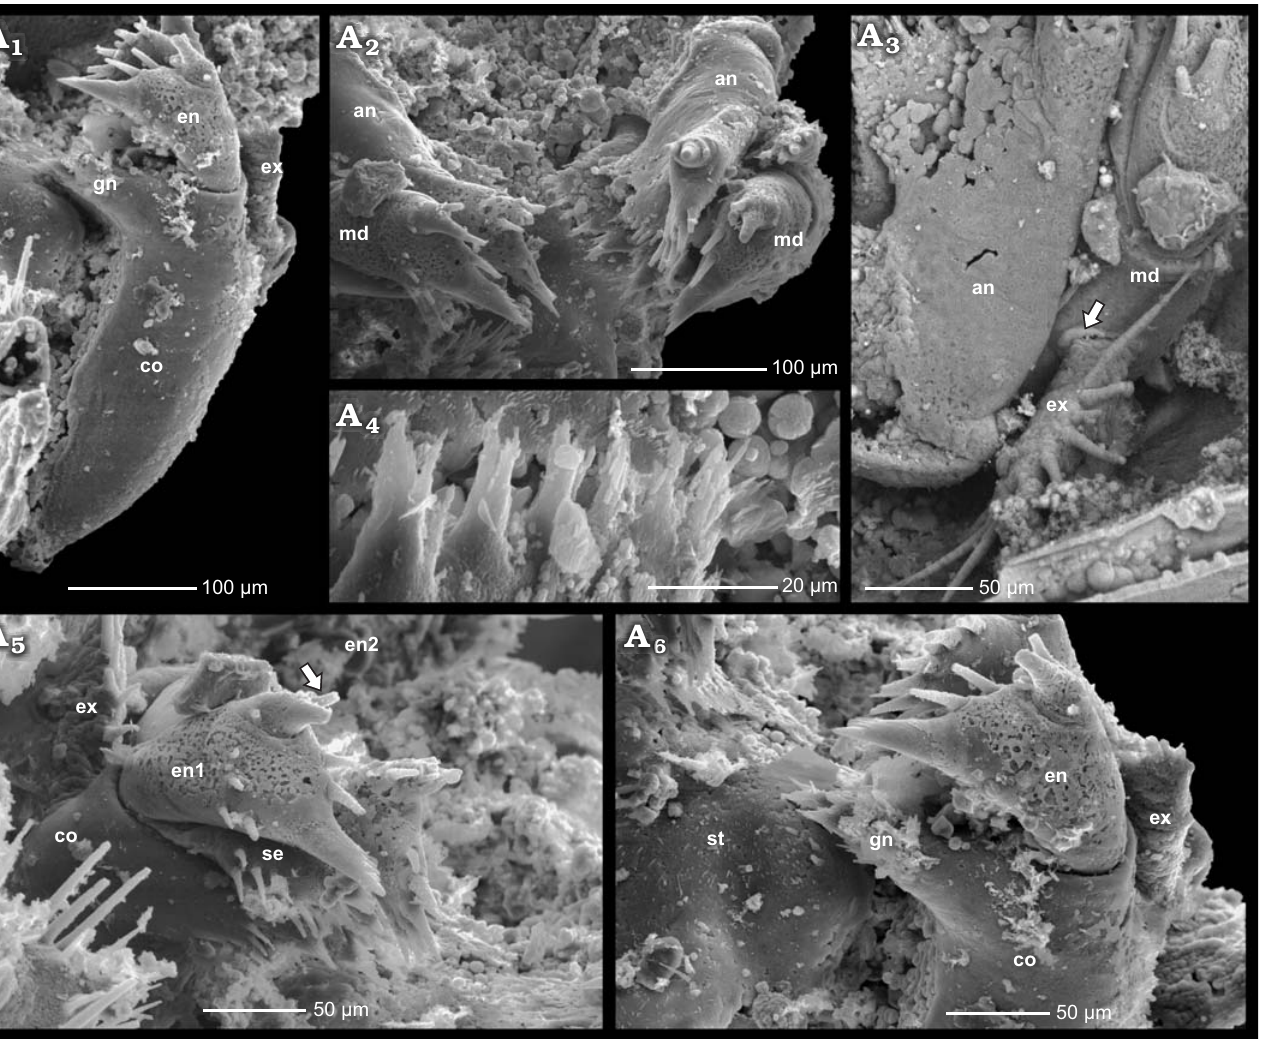
Fig. 4. Phosphatocopid crustacean Cyclotron angelini (Linnarsson, 1875), ZPAL Cr.11/ph060 from the Olenus Biozone, Furongian, D ę bki 2 borehole, northern Poland. Left mandible in posterior view, note the empty space left by the setose endite (“basipodal endite”) broken off between gnathobase of coxa and endopod (A 1 ); pairs of antennae and mandibles in oblique ventral view (A 2 ); proximal part of right antenna in anterior view; note coxa of man- dible with the circular cuticular structure around the exopod (arrow) (A 3 ); margin of left coxal gnathobase with tuft-like setae (A 4 ); distal part of right mandible with part of coxa, setose endite (“basipodal endite”) and two-divided endopod (arrow) (A 5 ); distal part of left mandible with preserved coxa and endopod, note sternum with left paragnath; setose endite (“basipodal endite”) is not preserved (A 6 ). Abbreviations: an, antenna; co, coxa; en, endopod; ex, exopod; gn, gnathobase; md, mandible; se, setose endite; st,